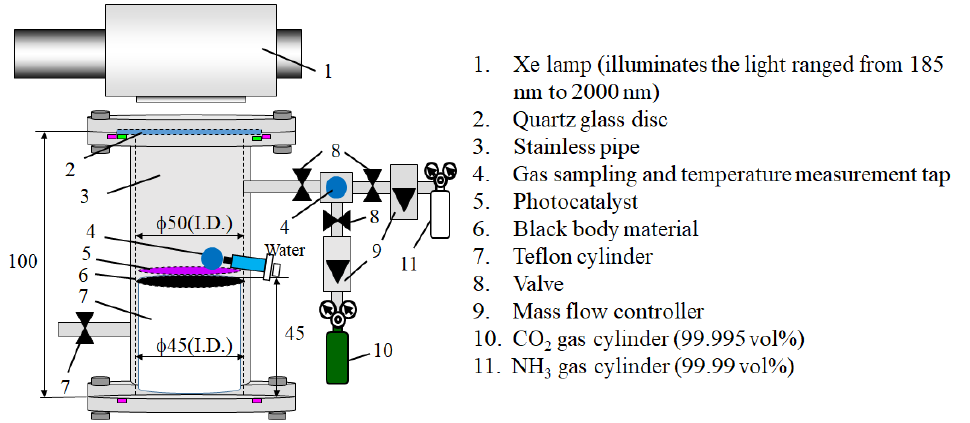
Figure 6. Schematic diagram of CO 2 reduction experimental apparatus. The reactor consists of stainless pipe, TiO 2 film photocatalyst positioned on Teflon cylinder, a quartz grass disc, a 150 W Xe lamp, mass flow controller, CO 2 gas cylinder, and NH 3 gas cylinder.